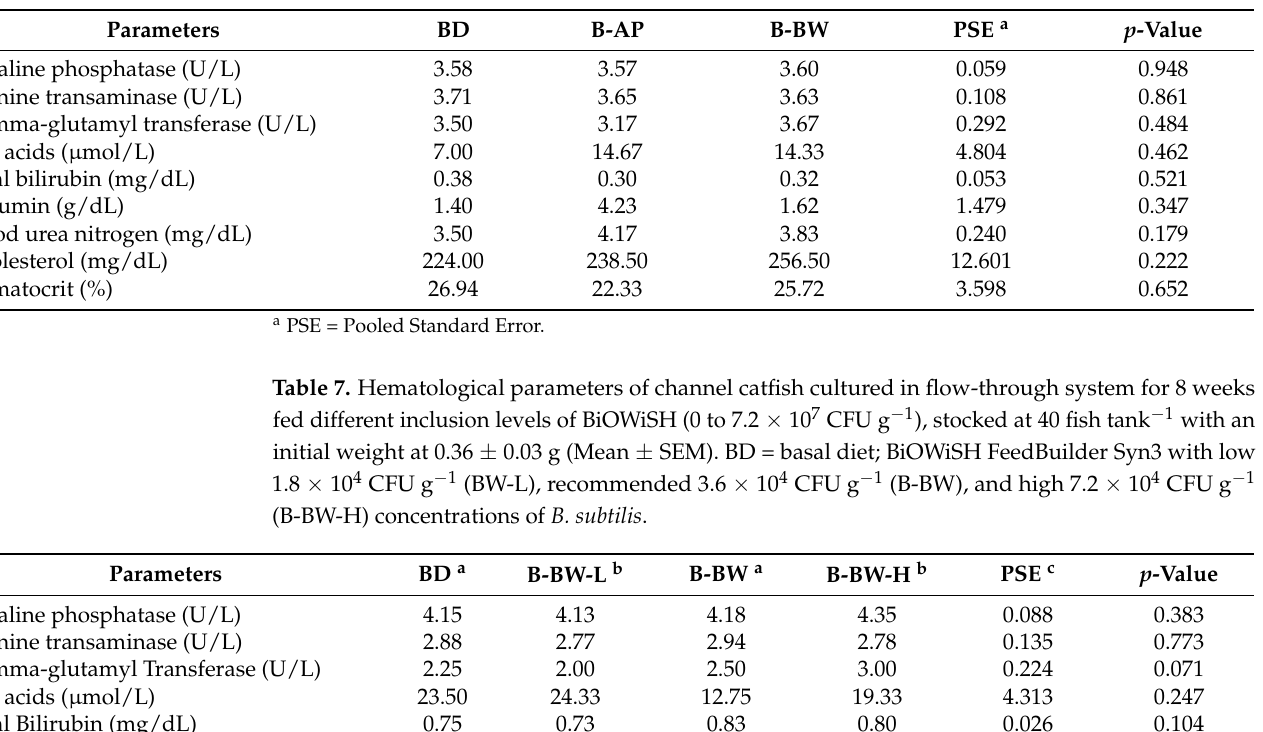
Table 6. Hematological parameters of channel catfish cultured in flow-through system for 6 weeks fed different probiotics, stocked at 10 fish tank − 1 with an initial weight at 34.80 ± 12.53 g (Mean ± SEM).